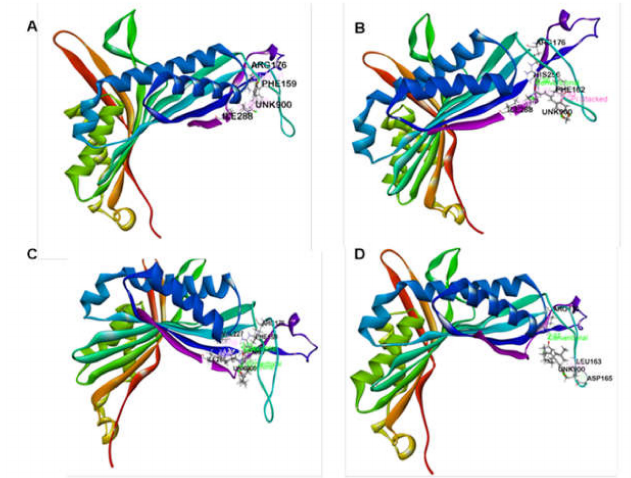
Figure 4. Best ranked pose of piperine ( A ), piperlonguminine ( B ), sylvamide ( C ), and sylvatine ( D ) in the binding pocket of xanthine oxidoreductase (PDB: